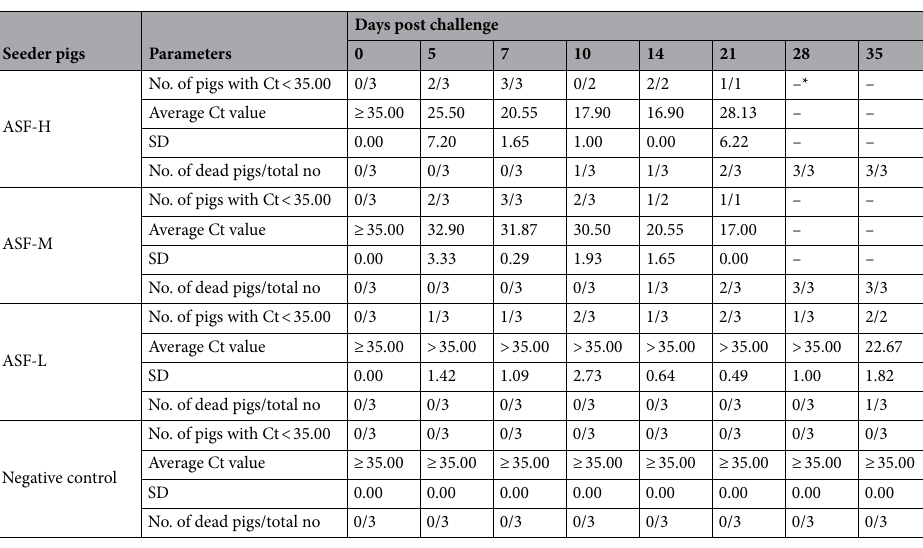
Table 2. Number of seeder pigs presenting ASFV viremia detectable by qPCR (Ct < 35), and number of dead pigs, over the 35 days following oronasal/intramuscular inoculation with the ASFV (challenge). *All pigs in the subgroup died.